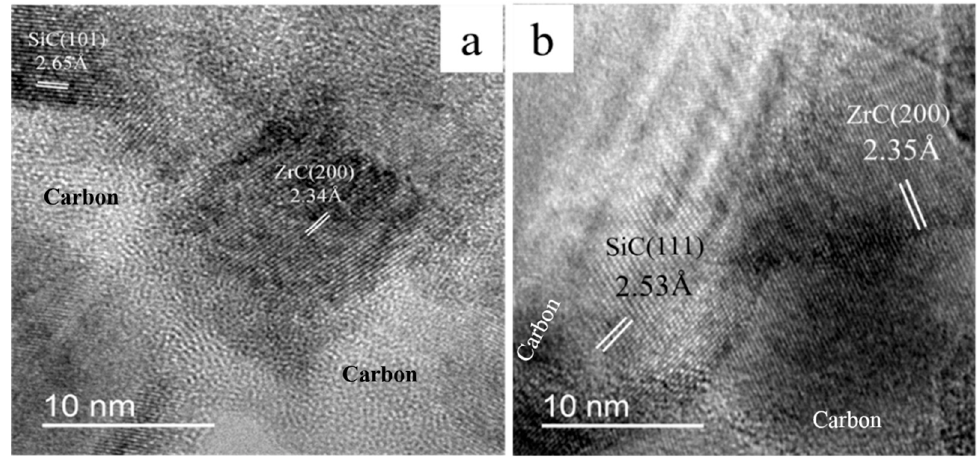
Figure 5. HR-TEM images of the as-cured fibers obtained via the Ar–Ar process up to ( a ) 1400 and ( b ) 1600 °C.